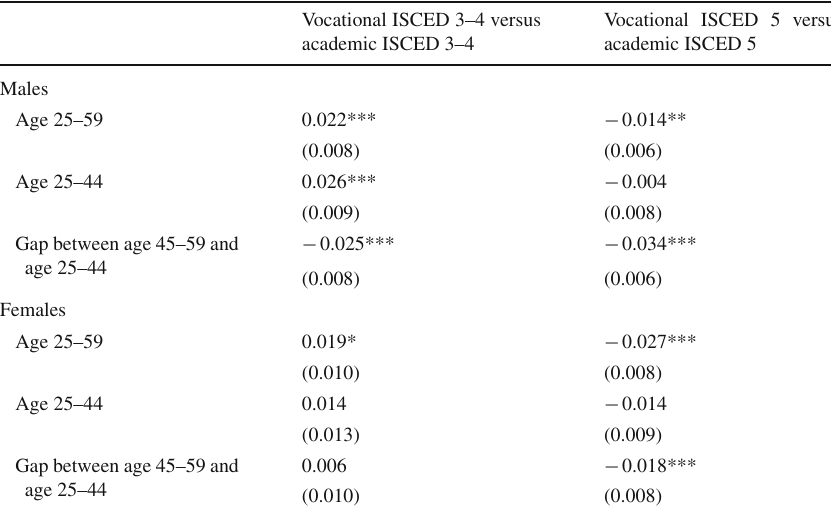
Table 8 Average treatment effects of vocational education relative to academic education. Dependent variable: current employment status. Source : Calculations based on PIAAC data Vocational ISCED 3–4 versus Vocational ISCED 5 versus academic ISCED 3–4 academic ISCED 5